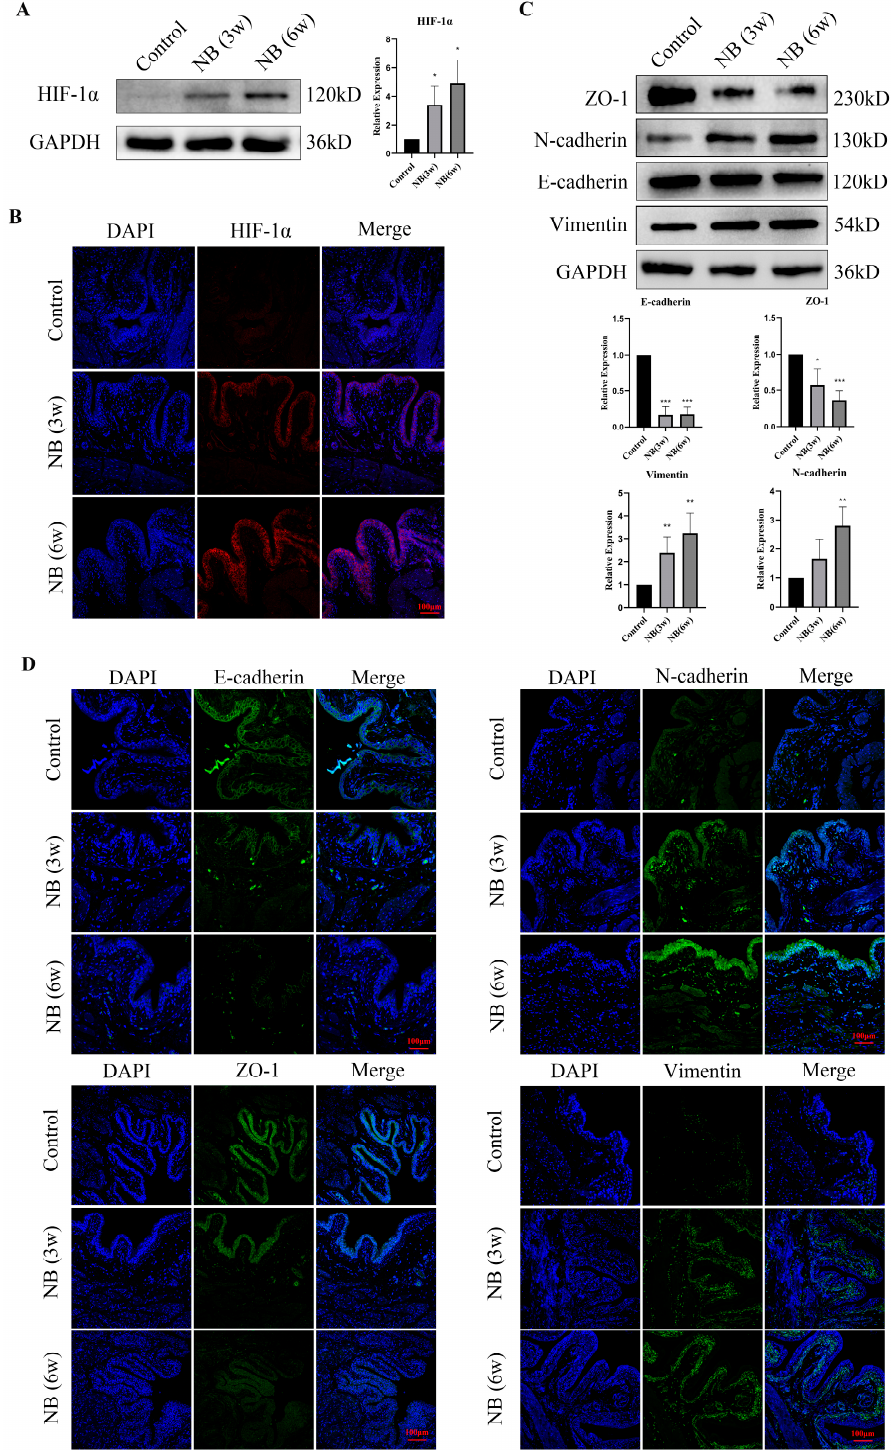
α and EMT were involved in bladder fibrosis in the bladder after SCI. ( A ) Western 3 Figure 3. HIF-1 blotting of HIF-1 α in bladder tissue at different time points after SCI. ( B ) Immunofluorescence of blad- der sections revealed that HIF-1 α was upregulated in the bladder epithelial layer. ( C ) Representative Western blot bands of Vimentin, N-cadherin, E-cadherin and ZO1 and their relative optical density in bladder tissue at different time points after SCI. ( D ) Immunofluorescence of bladder sections showed upregulation of Vimentin and N-cadherin and downregulation of E-cadherin and ZO1. Data are presented as the mean ± S.D. (n ≥ 3). * p < 0.05; ** p < 0.01; *** p < 0.001. Scale bars, 100 µ